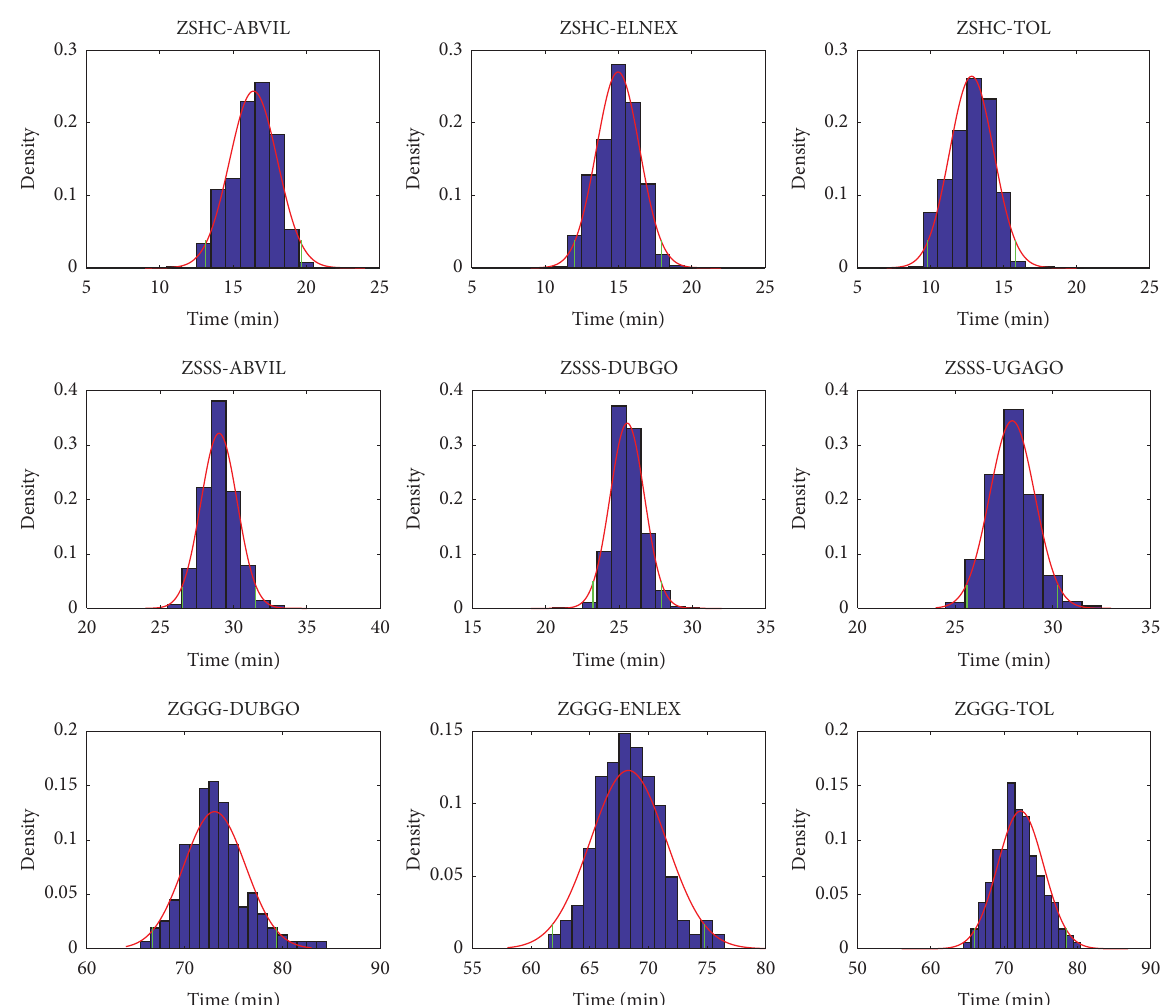
Figure 8: Distribution of fight time from diferent airports to diferent waypoints in Shanghai sector